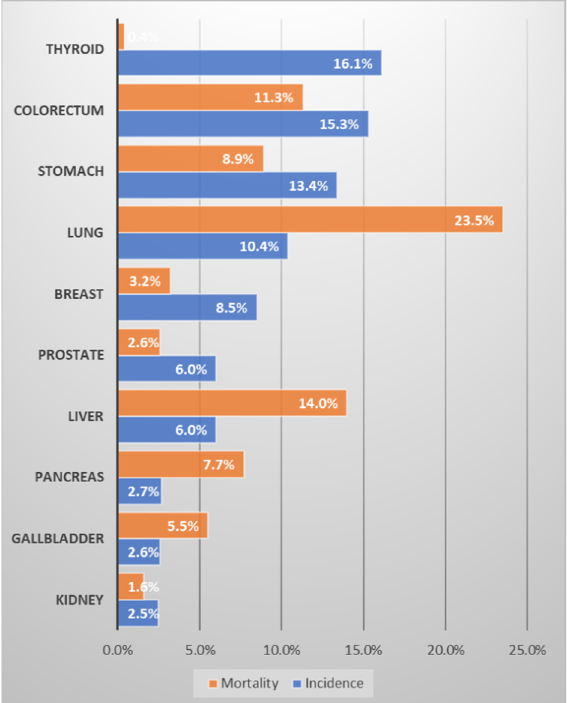
Figure 3. Ranking of the frequency and mortality of major cancers in Korea. Data source: Cancer country profile, WHO, 2020; Global Health Observatory, WHO, 2016. Figure drawn by authors [11,14]. 2. Breast Cancer